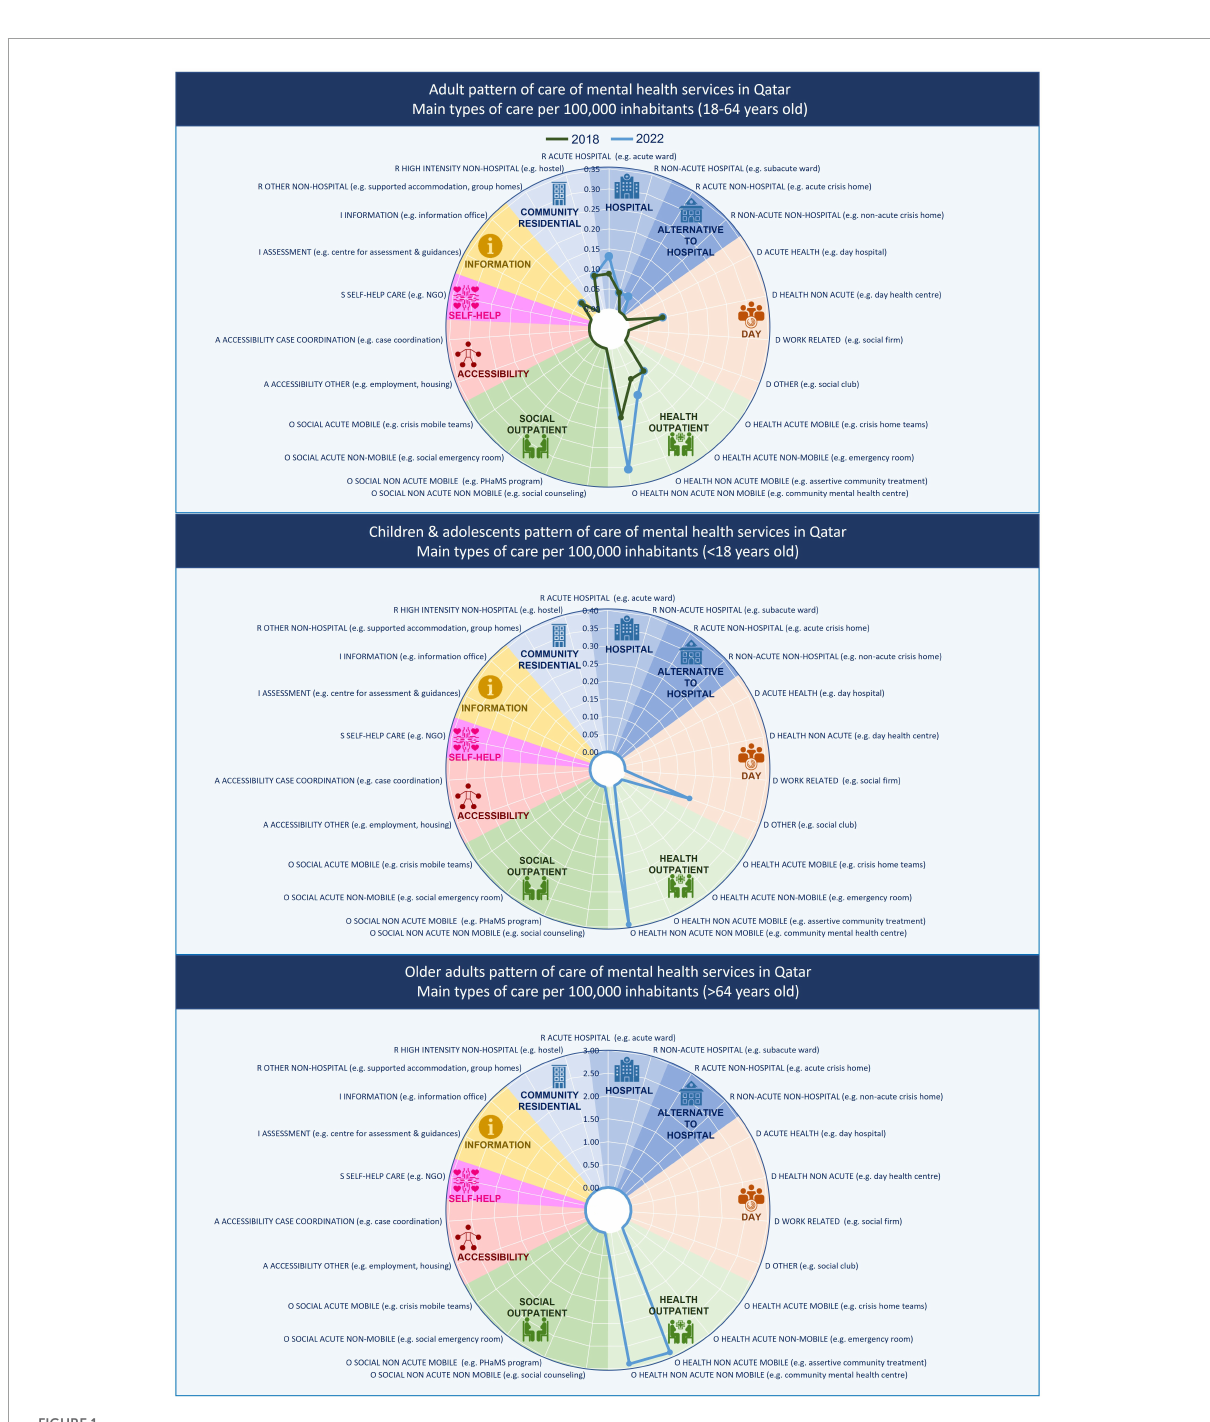
FIGURE1 Mental health service pattern by age group in Qatar (2018–2022).